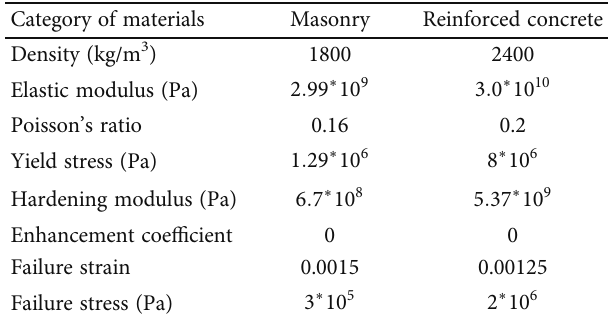
Table 1: Material parameters of complex steel structure model for mine